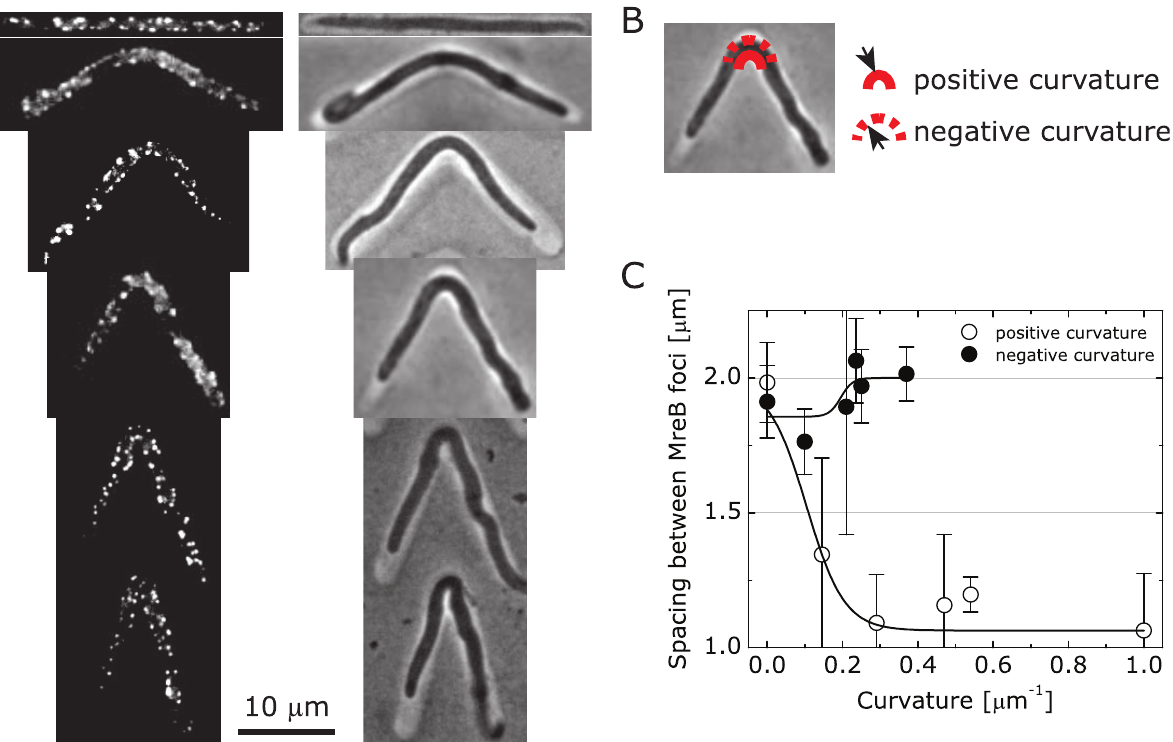
Figure 2. Analysis of MreB distribution in artificially curved bacterial cells. (A) Composite, representative fluorescence and bright field images of filamented E. coli FB76 cells in V-shaped channels depicting the spatial distribution of MreB-RFP. Scale bar: 20 m m. (B) An image depicting the positive and negative mean cytoplasmic membrane curvature imposed on the cell. (C) A plot depicting the spacing between MreB foci as a function of mean cell wall curvature determined for cells isolated in V-shaped microchannels and imaged using fluorescence microscopy. The plot depicts the spacing between MreB foci along the positively and negatively curved cytoplasmic membranes in confined cells. The lines between the data points are provided as a guide. For each value of channel curvature, we measured n $ 30 cells; error bars represent standard error of the mean.